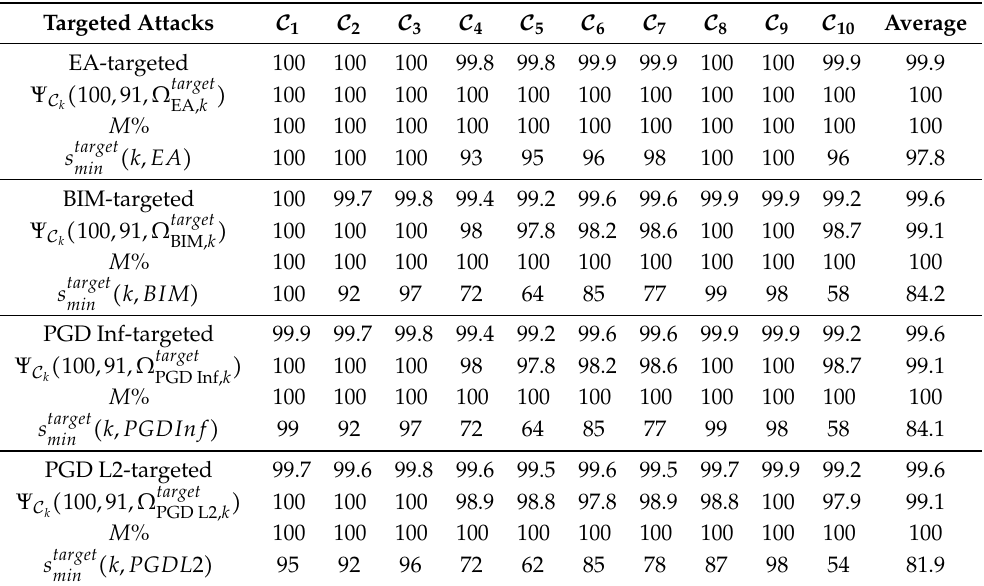
Table 6. For each C k , for each targeted attack atk , percentage s of the 100 permutations σ for which the (A p q )) , is declared shuffled-by σ image of an adversarial image, namely ShuffleDetect C k σ (D atk , targeted k ( 100,91, Ω target ) , of the maximum possible detection rate adversarial on average, assessment of Ψ C adv , k k ( k , adv ) . M %, and of s target min